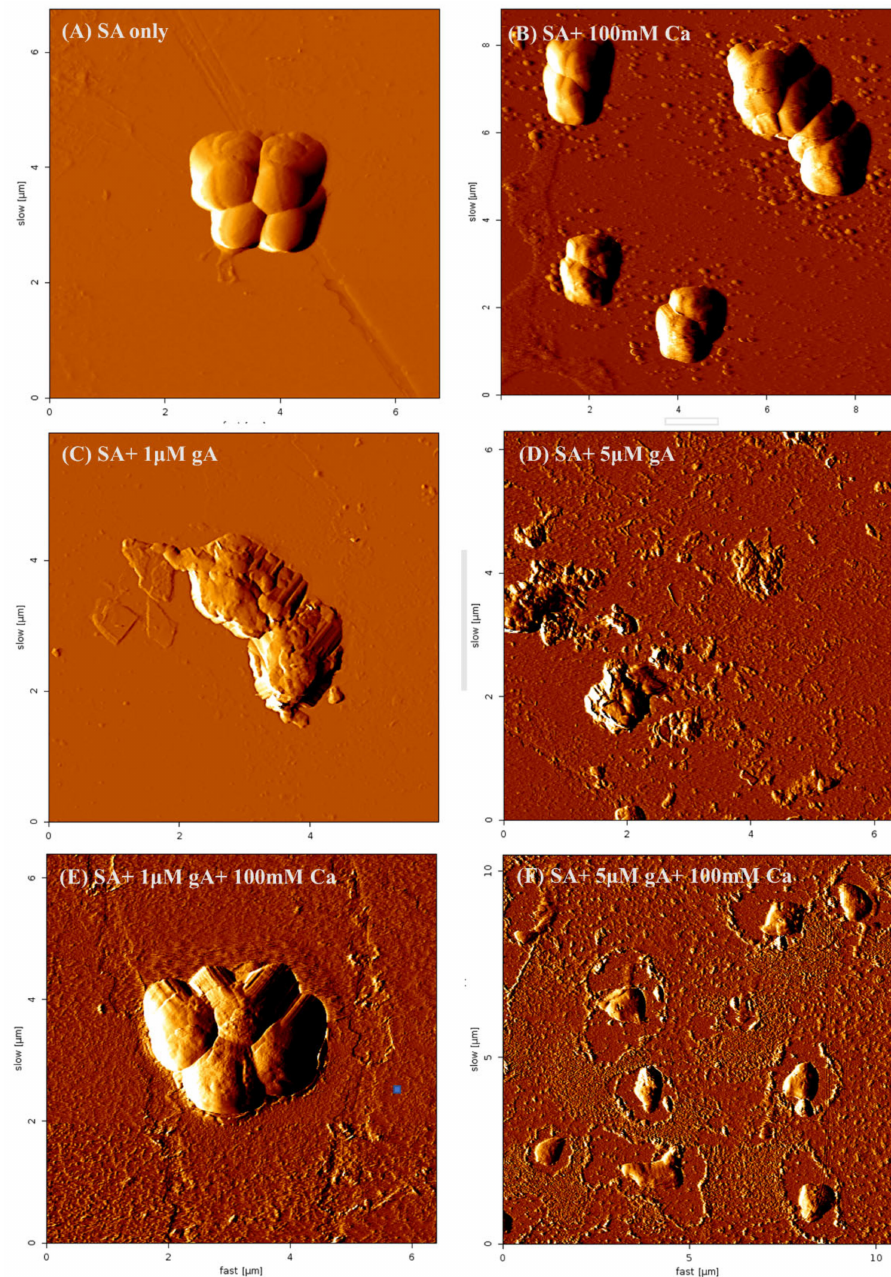
Figure 6. Atomic force microscopic morphologies of S. aureus under treatment with gramicidin A and CA 2+ ions, ( A ) S. aureus only without gA, ( B ) with 100 mM Ca 2+ ions, ( C ) with 1 µ M gA, ( D ) with 5 µ M gA, ( E ) with 1 µ M gA and 100 mM Ca 2+ ions and ( F ) with 5 µ M gA and 100 mM Ca 2+ ions. By adding 100 mM Ca 2+ ions to the culture medium, the morphologies of S. aureus for the treatment of 1 and 5 µ M gA (SA + 1 µ M gA + 100 mM Ca 2+ and SA + 5 µ M gA + 100 mM Ca 2+ in Figure 6E,F, respectively) were different. The morphologies of S. aureus in the presence of 1 µ M gA and 100 mM Ca 2+ ions were round, smoothed, and clumping to each other similar to the morphologies for S. aureus without the treatment of gramicidin A (Figure 6A,B), indicating that Ca 2+ ions can effectively inhibit the gA-induced bacterial death. Unlike the morphologies that appeared in the presence of 1 µ M gA and 100 mM Ca 2+ ions, the morphologies of S. aureus lost the integrity of the membrane surface, round shape, and clumping in the presence of 5 µ M gA and 100 mM Ca 2+ ions, suggesting that Ca